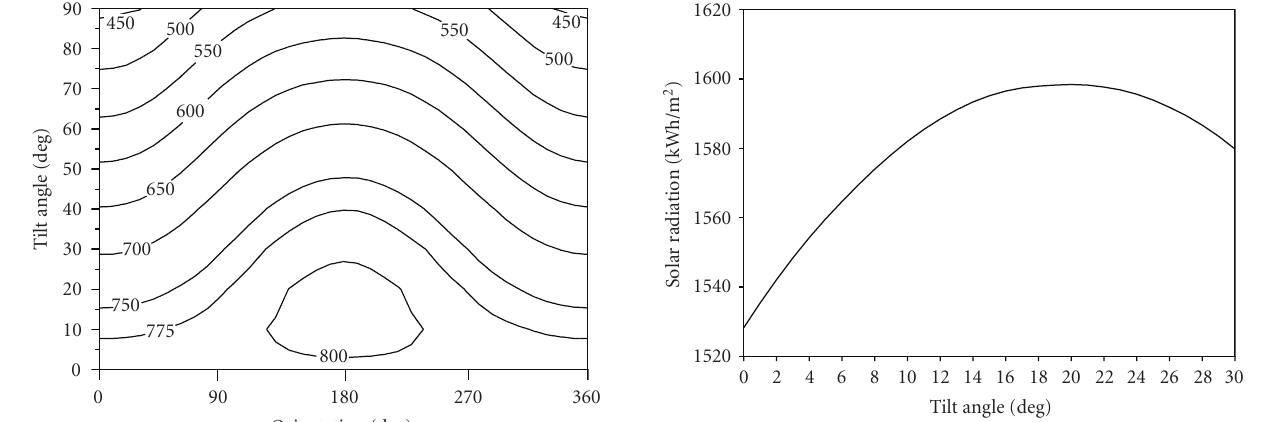
Figure 4: Annual sky-di ff use and reflected solar radiation (kWh/m 2 ) for various tilt angles and orientations.